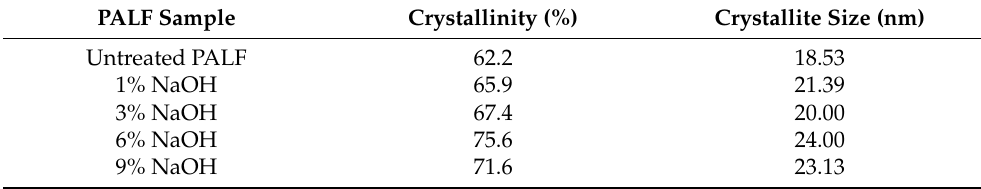
Figure 3. XRD pattern of ( a ) untreated PALF, ( b ) 1, ( c ) 3, ( d ) 6, and ( e ) 9% NaOH treated PALFs. The 9% wt/wt NaOH treatment splitted the (101) reflection peak at 15.1 ◦ 2 θ position. Table 2. Summary of crystallinity and crystallite size of untreated and differentially NaOH treated PALF